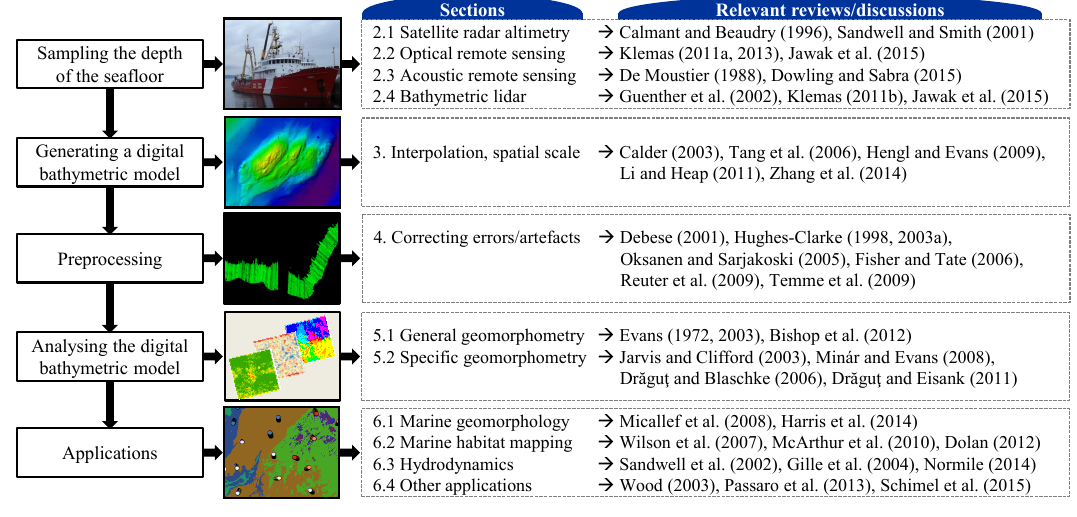
Figure 1. Geomorphometry is commonly implemented in five steps (Pike et al., 2009; Bishop et al., 2012), here adapted to the application of geomorphometry to the marine environment (left). The panels on the right describe the structure and elements addressed in Sects. 2 to 6 of this paper, and list reviews and important discussion papers on these